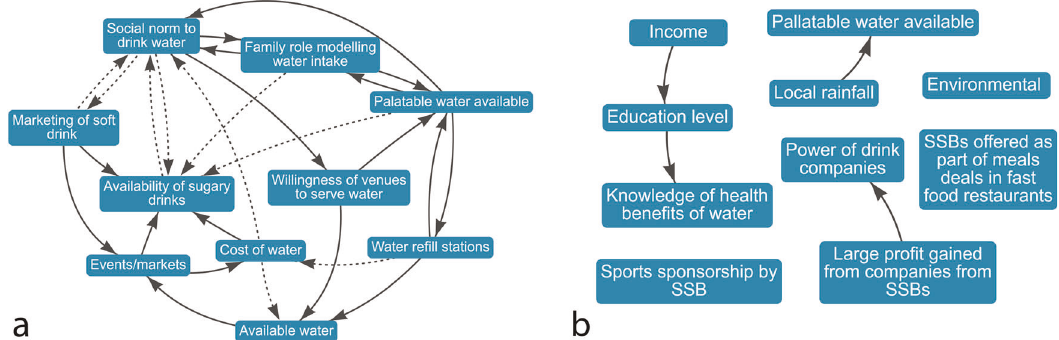
Fig. 3 Example of candidate diagrams produced by the pruning analyses. a A viable diagram produced by one analysis approach, with factors interconnected in a single uni fi ed network of causes and effects, as is typical of a causal diagram. b A non-viable diagram, where the analysis selected variables that were not directly connected in the merged diagram. This resulted in a candidate with few causal connections, and little utility in communicating